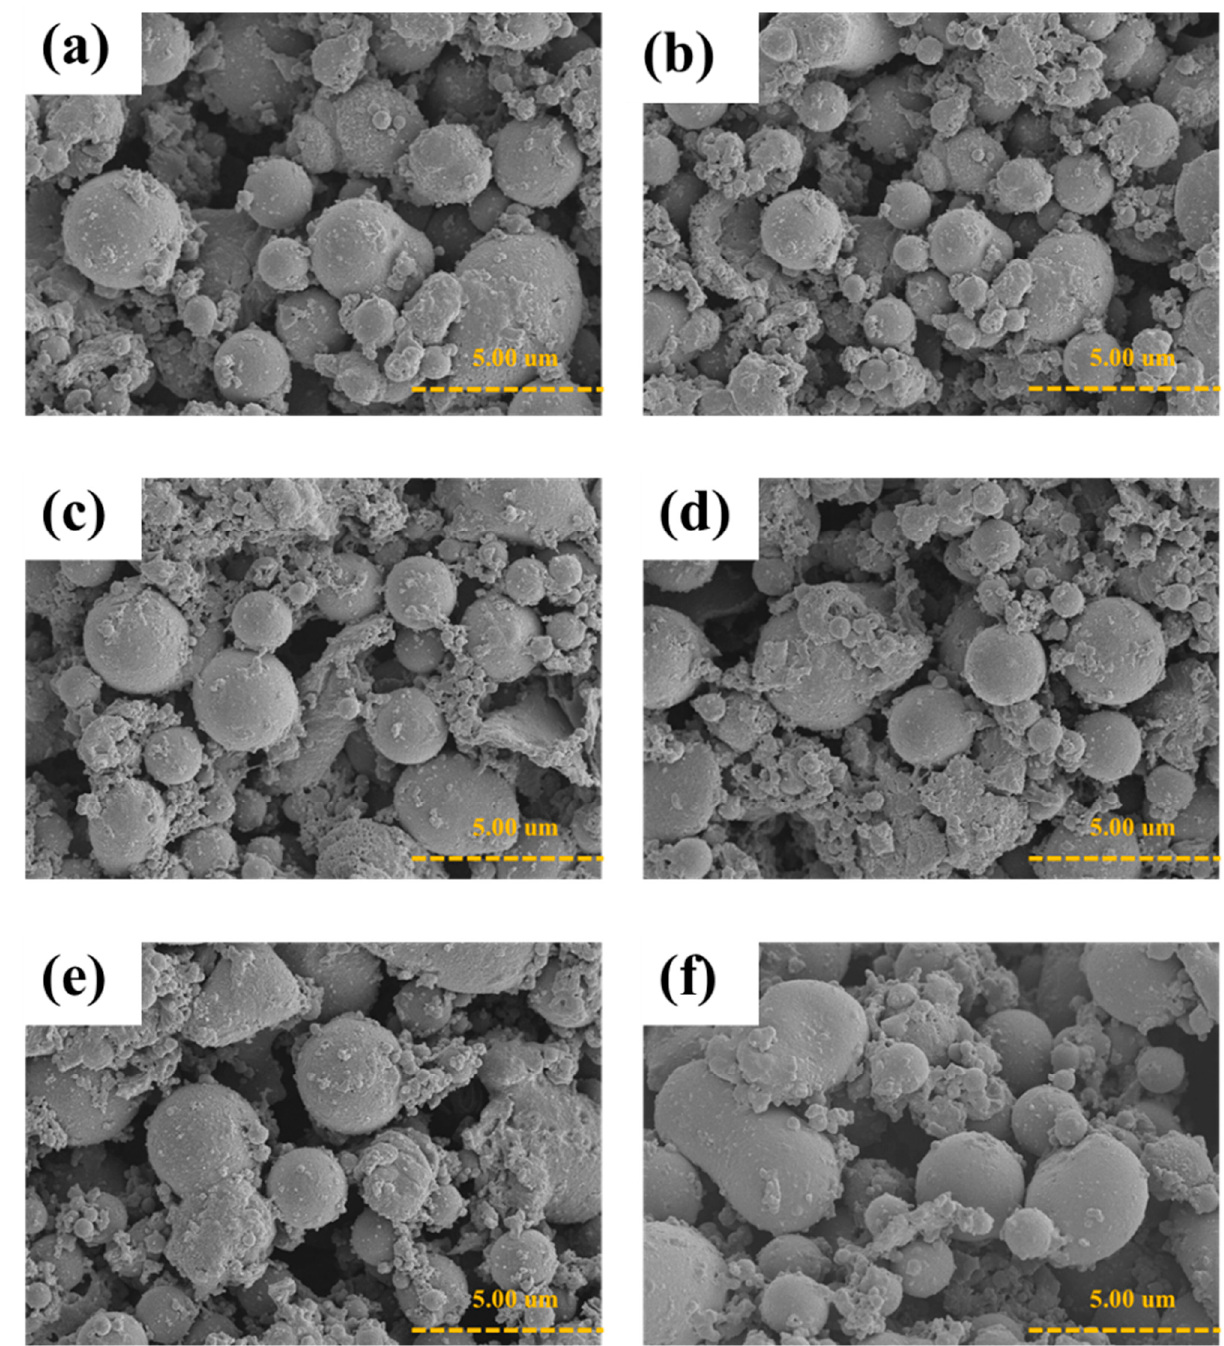
Figure 7. SEM images of HClO 4 doped P3HT_DBSA synthesized at various doping levels: ( a ) dP3HT_DBSA (1:1); ( b ) dP3HT_DBSA (5:1); ( c ) dP3HT_DBSA (10:1); ( d ) dP3HT_DBSA (25:1); ( e ) dP3HT_DBSA (50:1); and ( f ) dP3HT_DBSA (75:1).